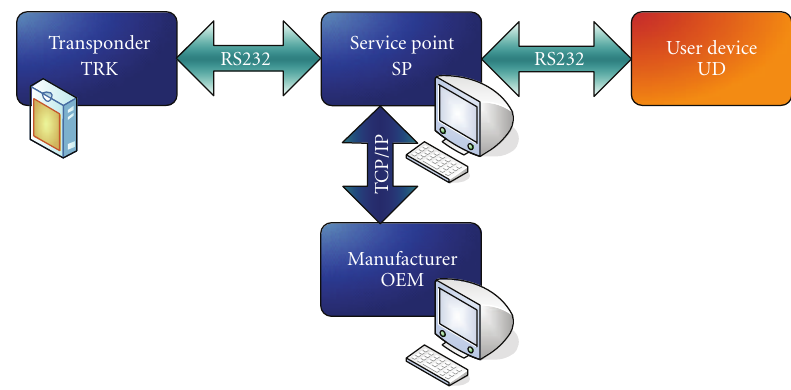
Figure 10: Component interaction.